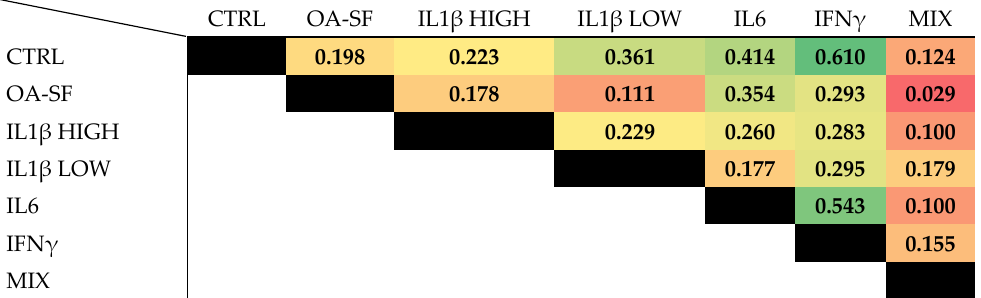
Values indicate R 2 . Background color shade indicates degree of correlation from red (lower correla- tion) to green (higher